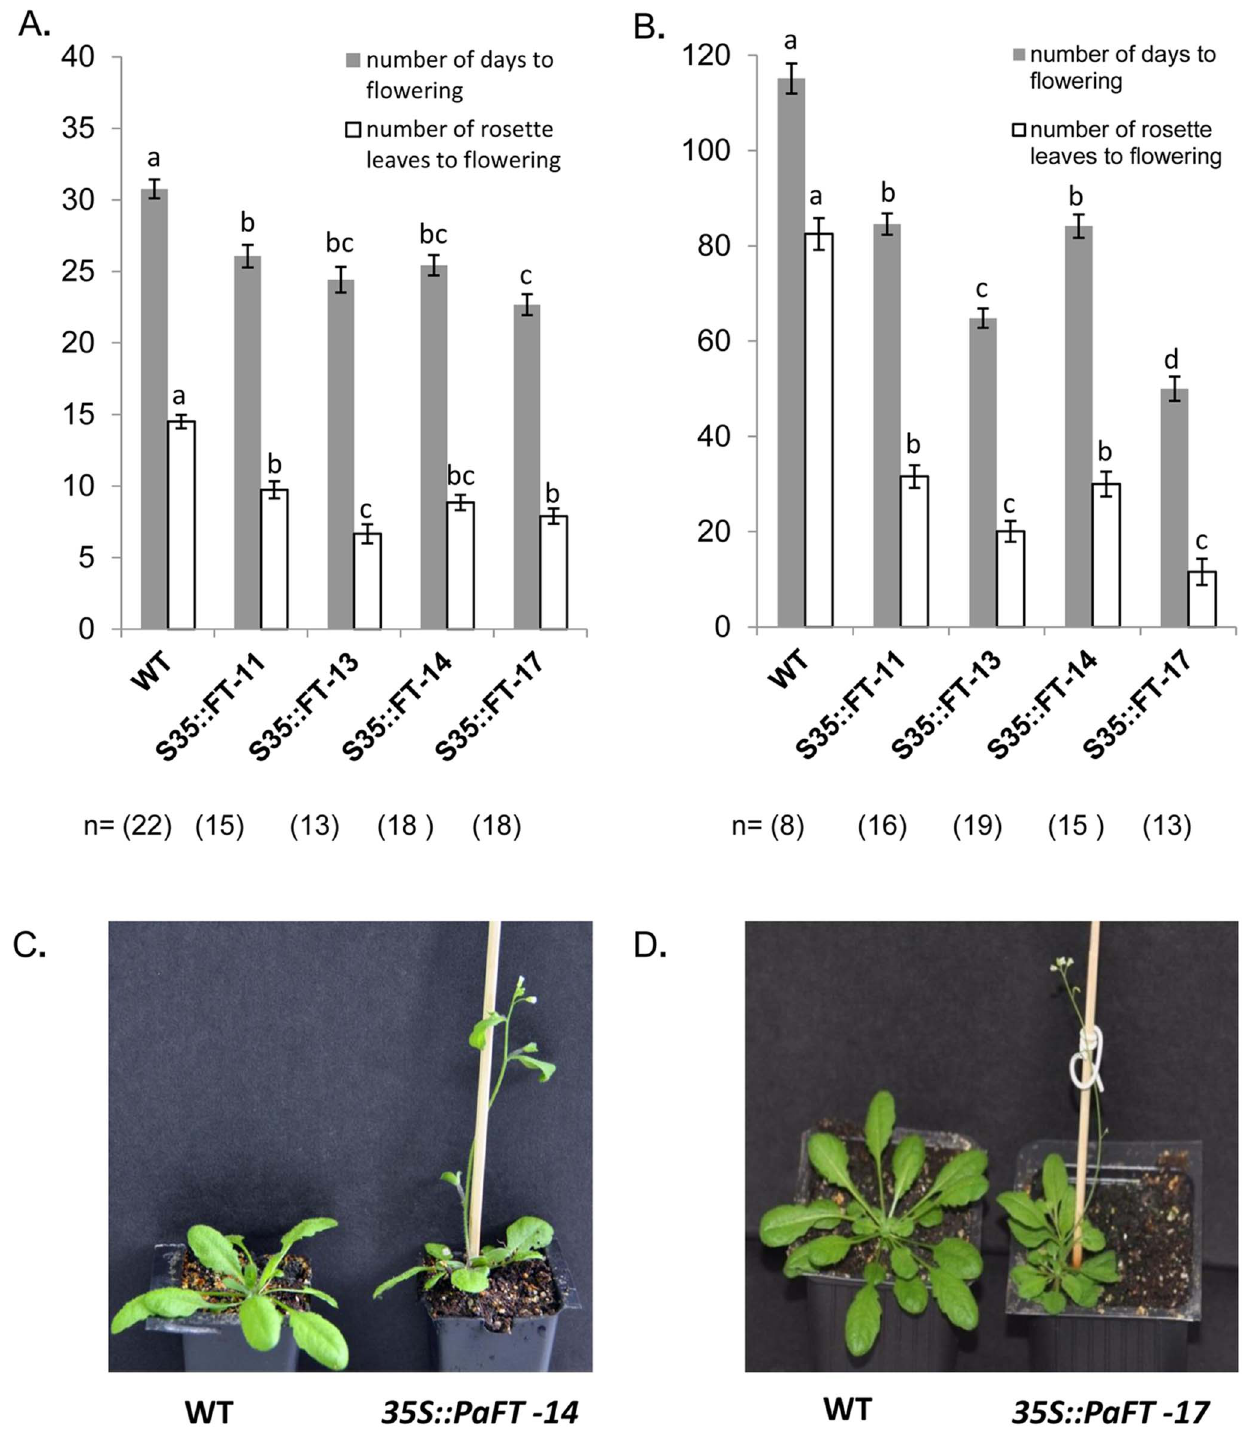
Figure 6. Ectopic expression of PaFT in Arabidopsis . Number of days to flowering and the number of rosette leaves at flowering of wild type plants and four randomly selected lines that constitutively expressed PaFT under LD ( A ) or SD ( B ) conditions are shown. Values represent means 6 SE of n=8-22 plants per treatment and different letters indicate significant differences. Two randomly selected transforemed lines that constitutively expressed PaFT exhibiting early flowering phenotype relative to wild type plants under LD ( C ) and SD ( D ) conditions are shown. Photographs were taken after 22 ( C ) and 48 days ( D ). doi:10.1371/journal.pone.0110613.g006 encoding genes are expressed in leaves and only the FT protein on (fully loaded) and off-like (July de-fruited) trees, shown to go through flower transition. Notably, in model organisms, FT seems to move towards the meristem. Interestingly however, in